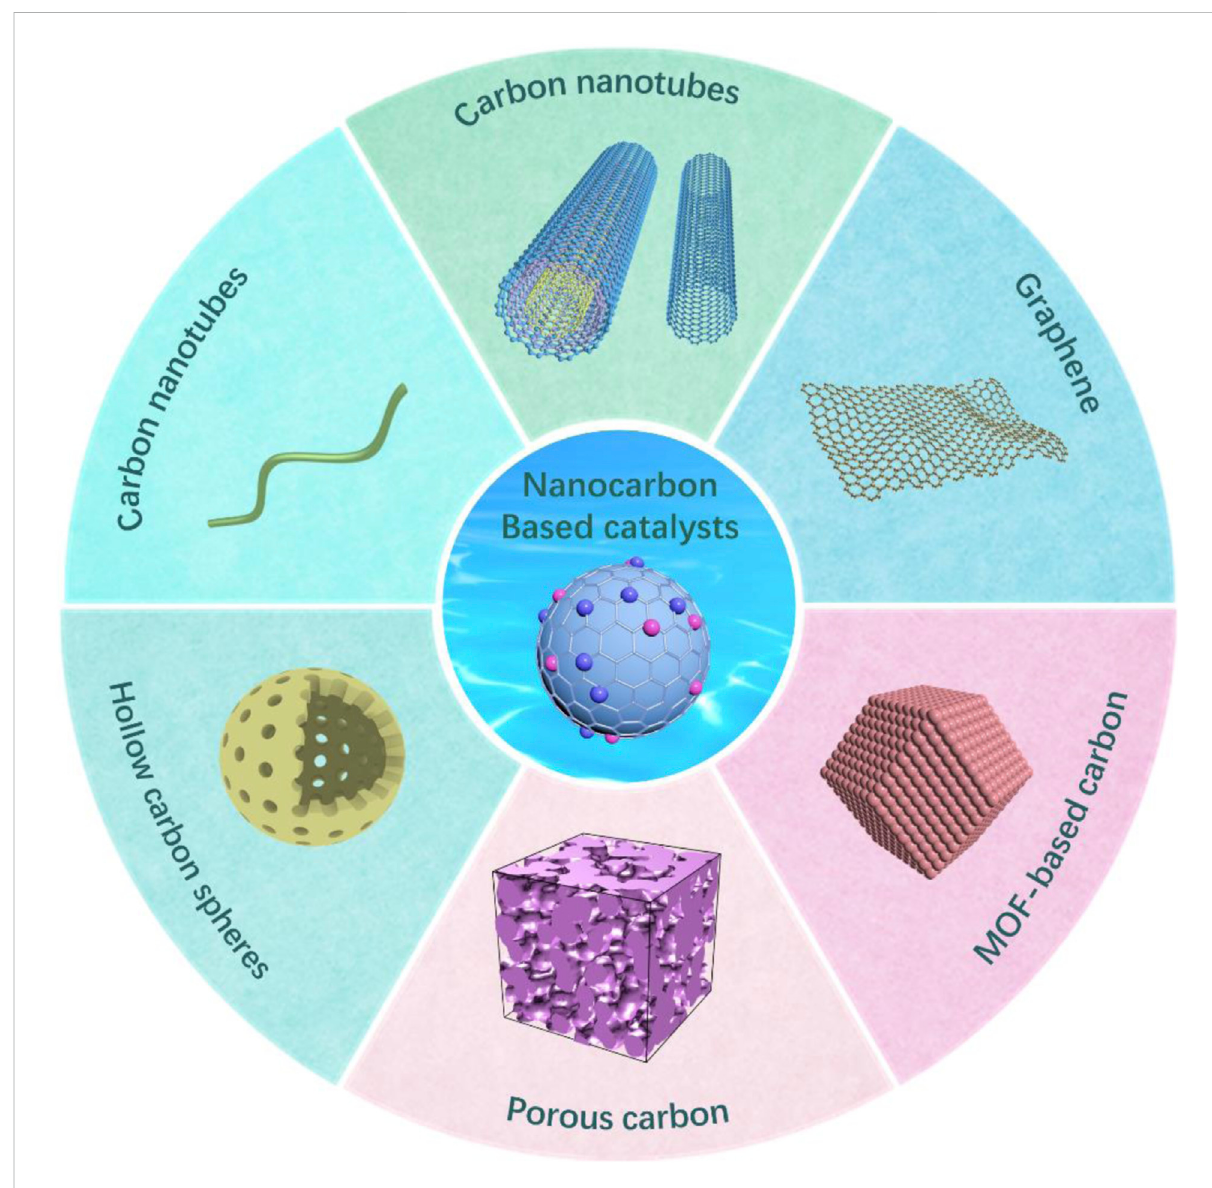
FIGURE 1 Schematic illustration of various nanocarbon-based materials for